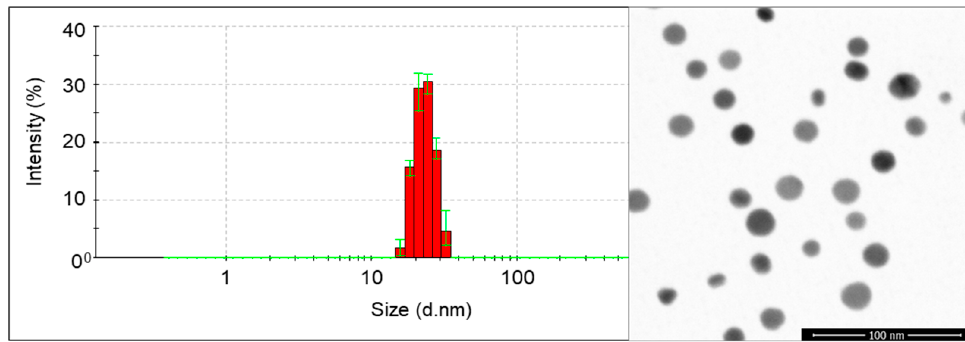
Figure 1. The DLS size distribution graph and STEM image (from the left) of the tested AgNPs (figures provided by courtesy the of Nanoparticles Innovation NPIN s.c., Ł ód ź , Poland).